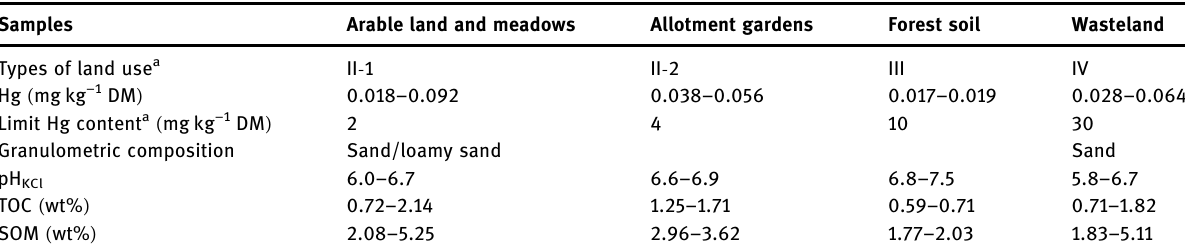
Table 2: Characteristics of soil samples